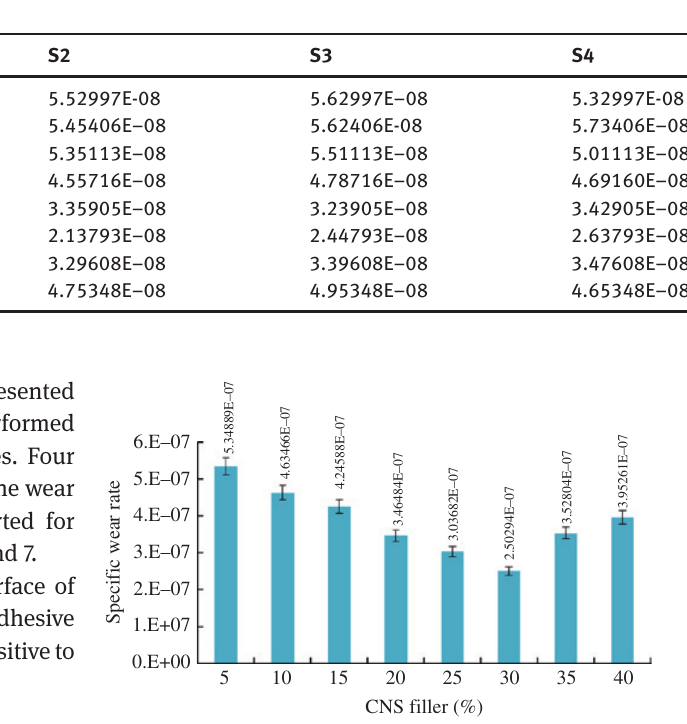
Table 2: Specific wear rates of the NaOH-treated CNS filler epoxy composites with various filler contents.